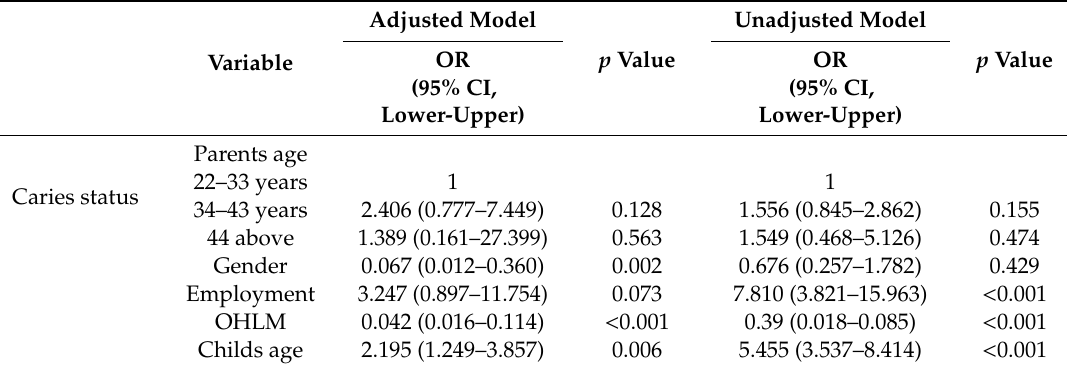
Table 6. Factors associated with dental caries: Regression